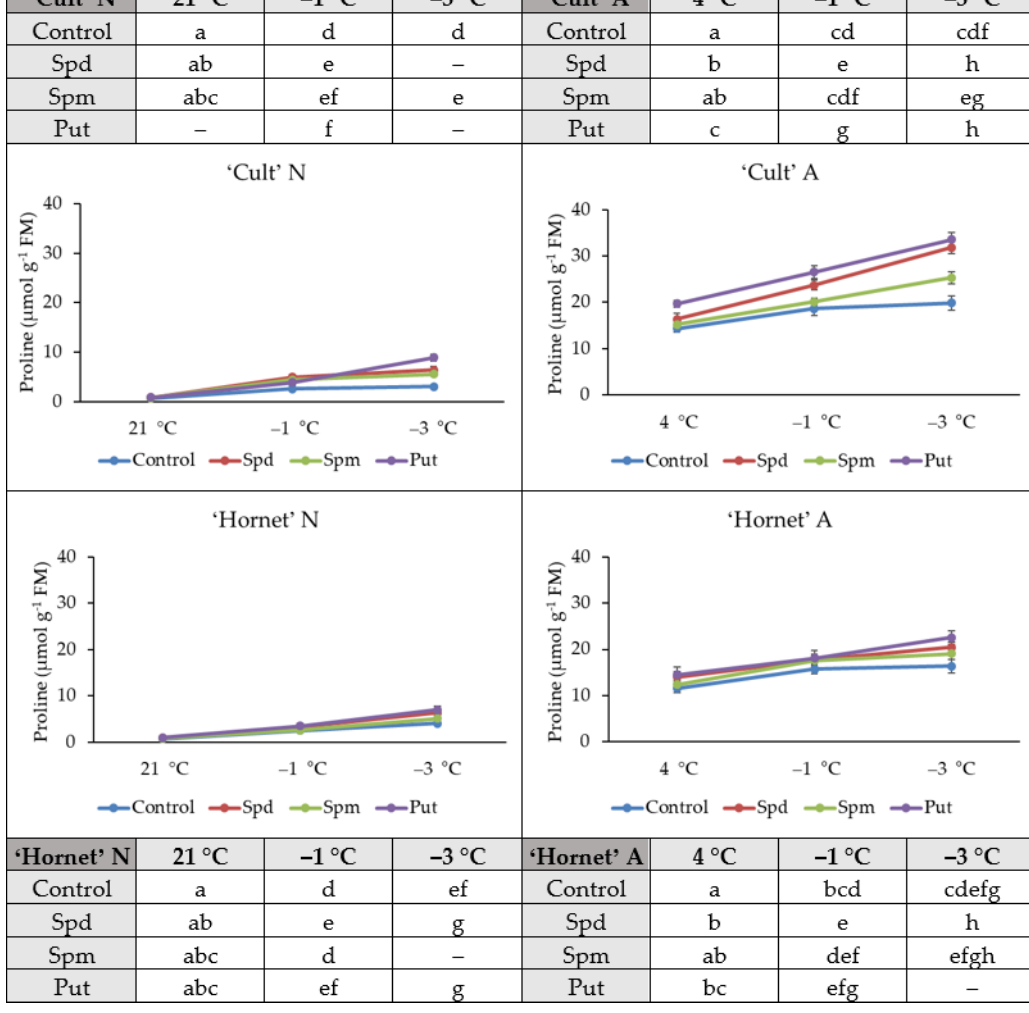
Figure 3. The effect of PA application, cold acclimation (4 °C, 4 days), and increasing cold treatment (from –1 to –3 °C, 2 days) on winter oilseed rape proline accumulation. Error bars represent the standard deviation of the mean. Control, Spd, Spm, and Put indicate the type of application. Capital letters N and A indicate non-acclimation and acclimation, respectively. Different lowercase letters indicate statistically significant difference ( P < 0.05).